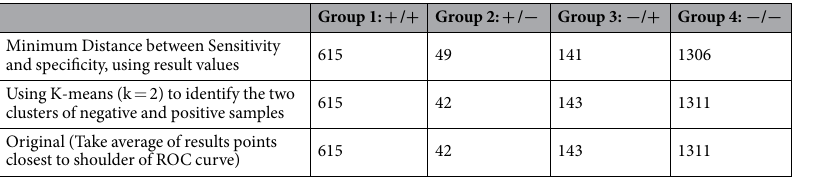
Antibody groups Group 1: + / +